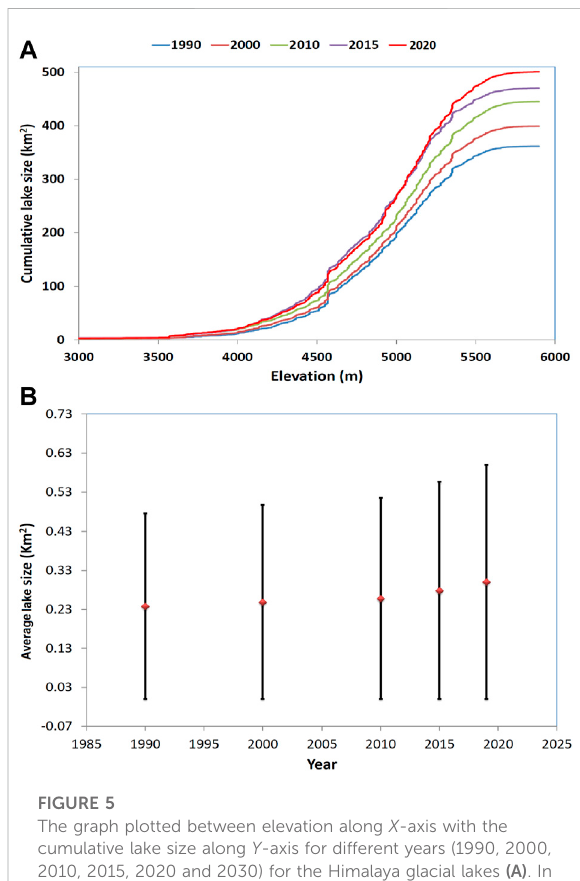
FIGURE 5 The graph plotted between elevation along X -axis with the cumulative lake size along Y -axis for different years (1990, 2000, 2010, 2015, 2020 and 2030) for the Himalaya glacial lakes (A) . In (B) , the average lake size was shown with standard deviation for different years.